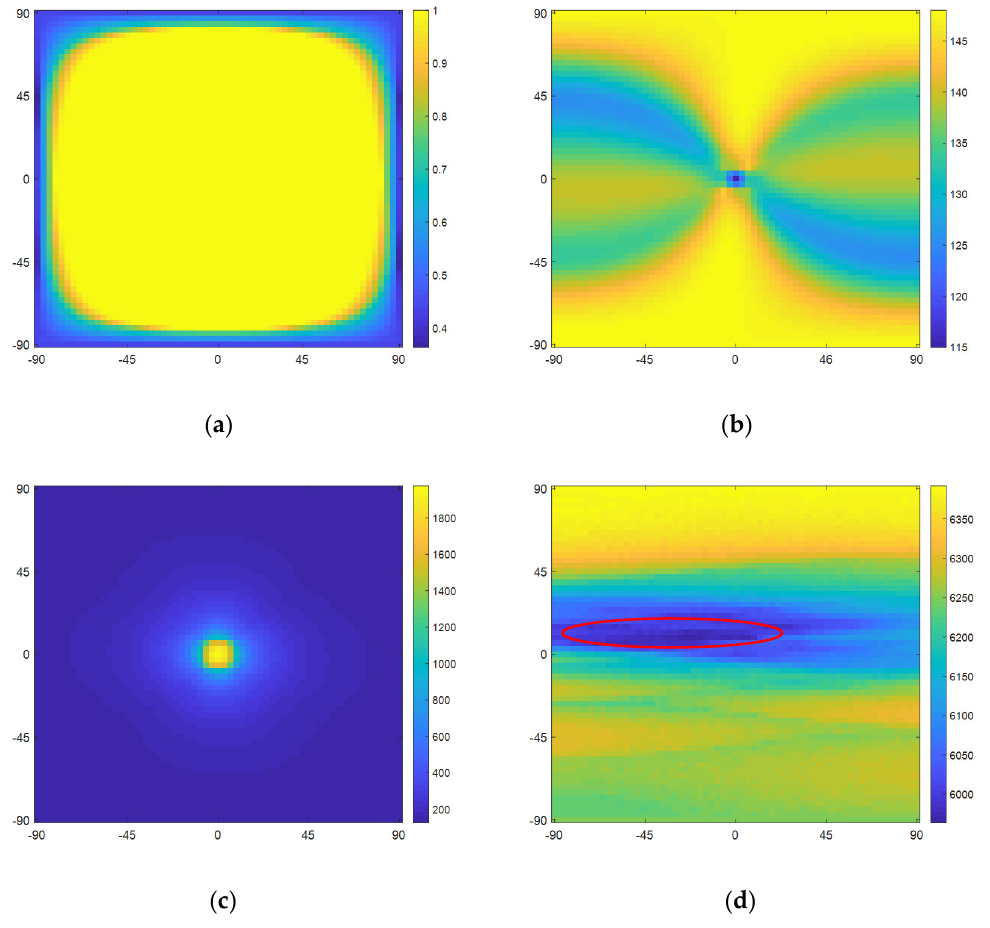
Figure 11. Four observational parameters put constraints on the observatory site selection: (a) the percentage of full coverage, (b) the mean derivative of elevation angle (arcsecond/hour), (c) the mean derivative of azimuth angle (arcsecond/hour), and (d) the number of times when LOS and the negative light direction toward the sensor (LOS-SUN) angle is smaller than FOV/2. The simulation step length is one minute from 2000/1/1 to 2019/1/1. The x and y coordinates indicate seleno-longitude and seleno-latitude, respectively.